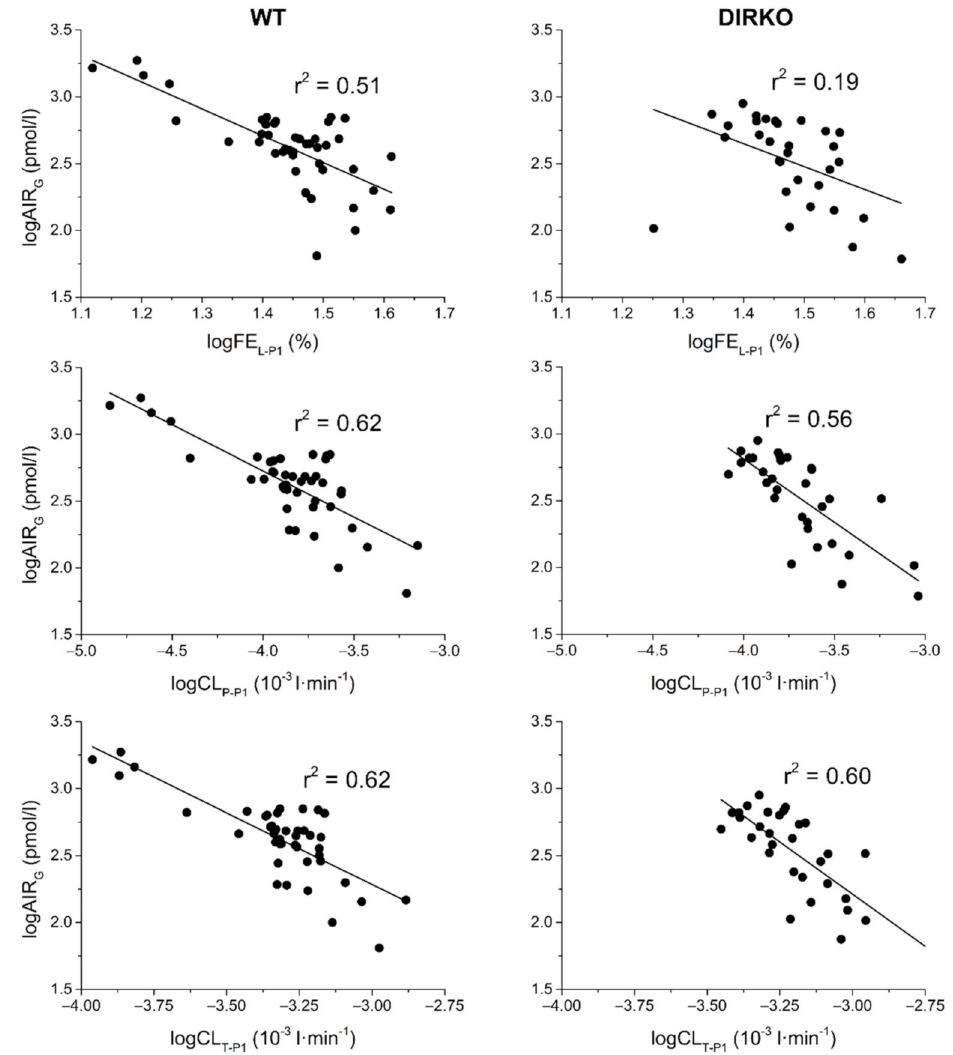
Figure 2. Most significant associations (r 2 ) of hepatic, extrahepatic, and total insulin clearance with metabolic parameters in DIRKO and WT mice. FE L-P1 , CL P-P1 , and CL T-P1 : hepatic, extrahepatic, and total clearance during the first phase of the test, respectively; AIR G : acute insulin response to